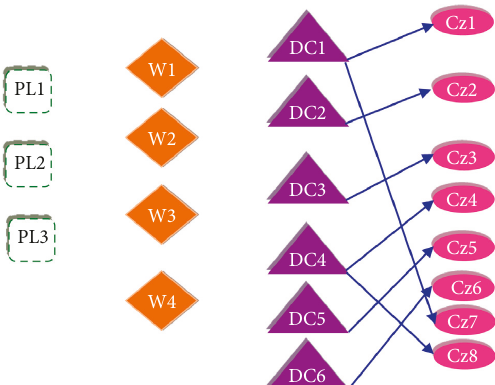
Figure 6: Network structure in year 3 and for the developed model with new financial aspects.